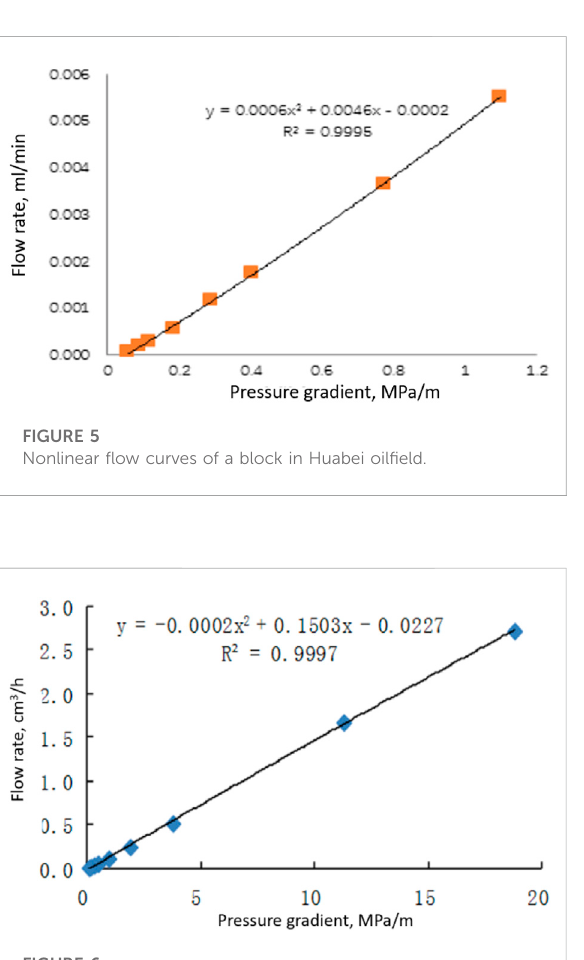
FIGURE 6 T2 nonlinear fl ow curves of a tight core in Jilin oil fi